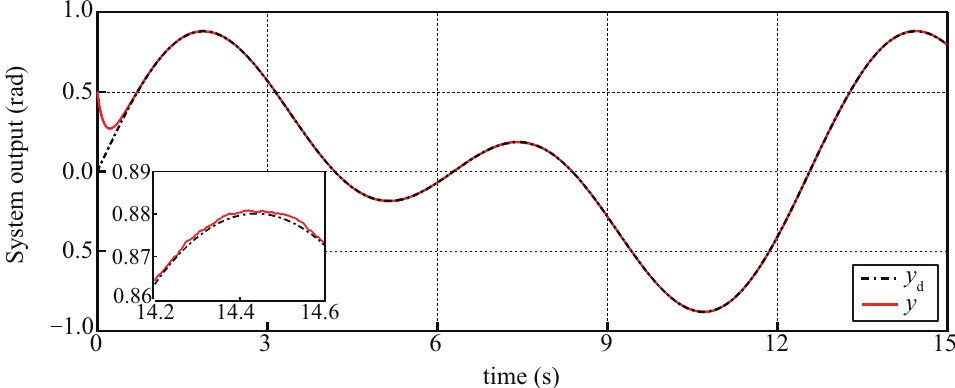
Figure 4. Tracking performance of the system output y under the proposed approach with noises.